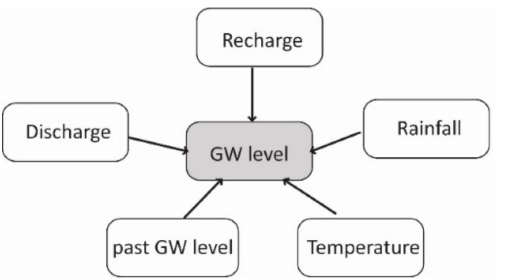
Figure 1. Example of the structure of a Bayesian model applied to groundwater-level